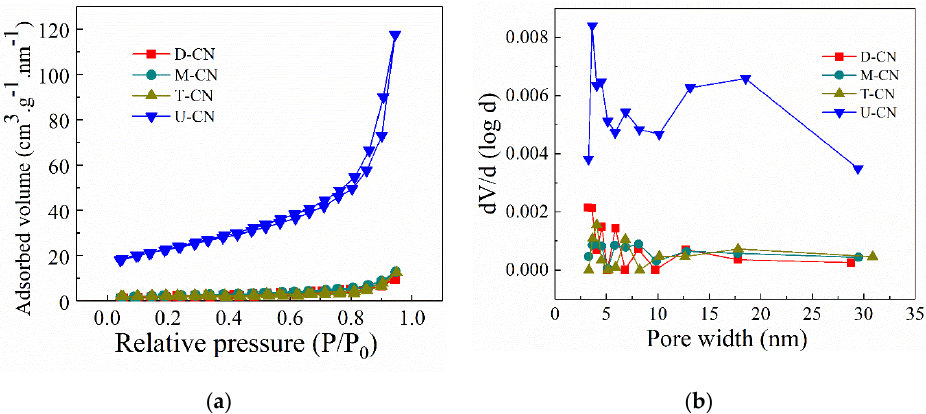
Figure 3. ( a ) N 2 adsorption-desorption isotherms and ( b ) corresponding pore size distribution curves of D-CN, M-CN, T-CN, U-CN.